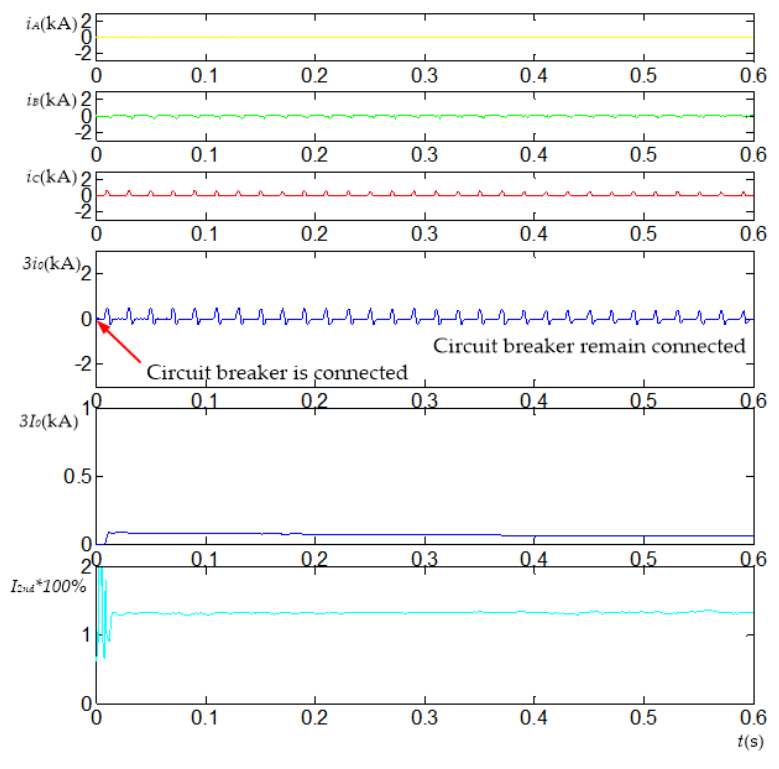
Figure A1. Recorded waveform Number One (0 – 3.4 s).